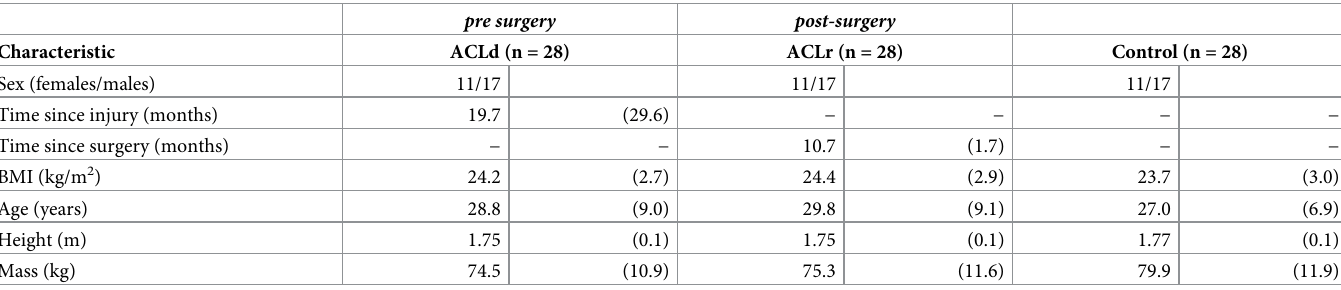
Table 1. Participant